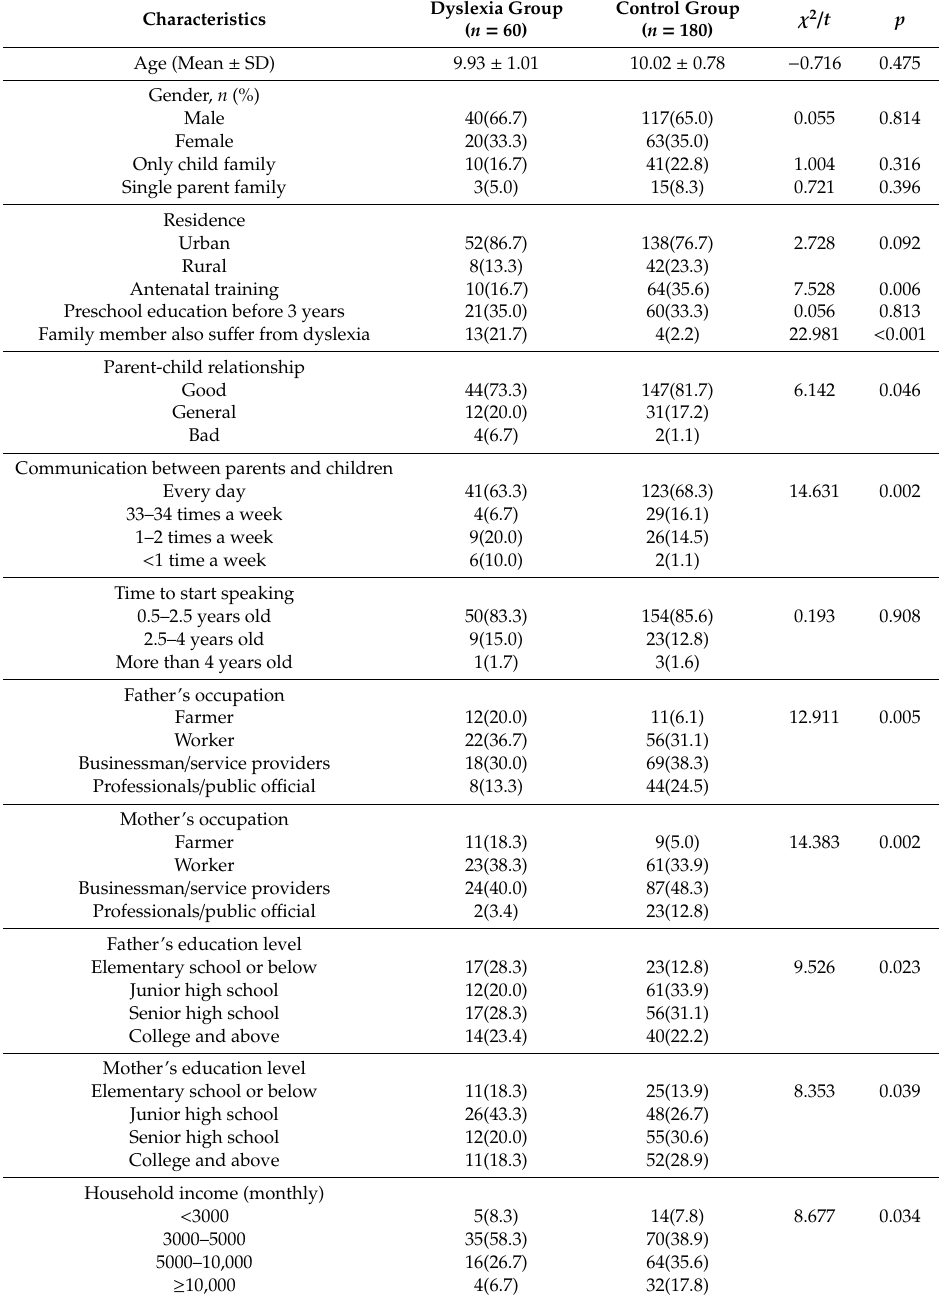
Table 1. General characteristics of the study